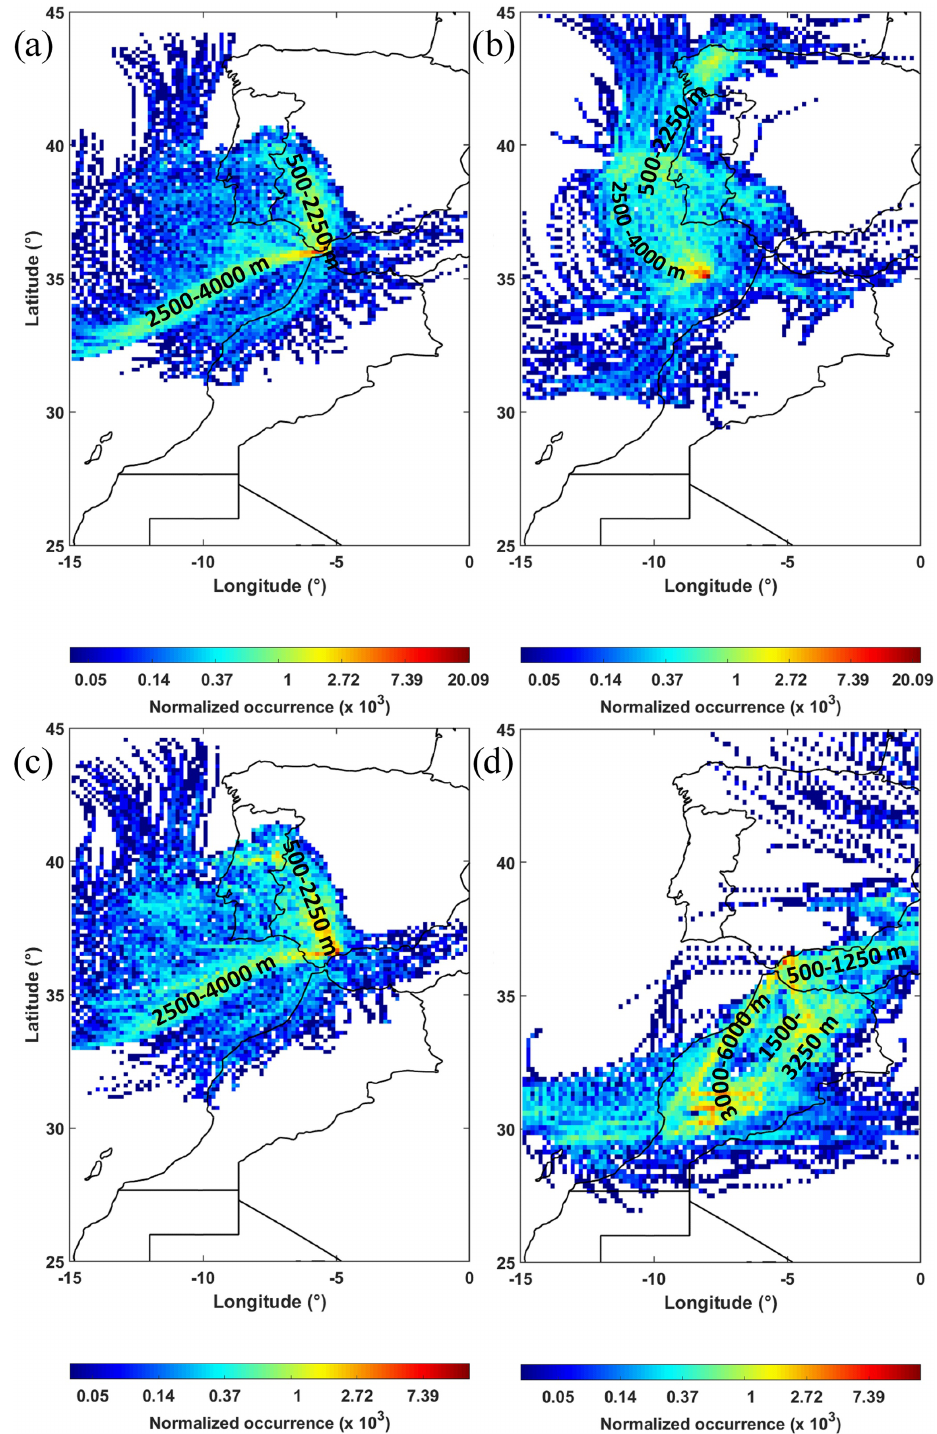
Figure 13. Bi-dimensional histogram derived from back trajectories computed using HYSPLIT on (a) 13 August 21:00UTC over the flight location, (b) 13 August 03:00UTC at the central position of CALIOP ground track off Gibraltar, (c) 13 August 21:00UTC over San Pedro Alcantara, and (d) 12 August 00:00UTC over San Pedro Alcantara. The aerosol transport altitudes are indicated for each main